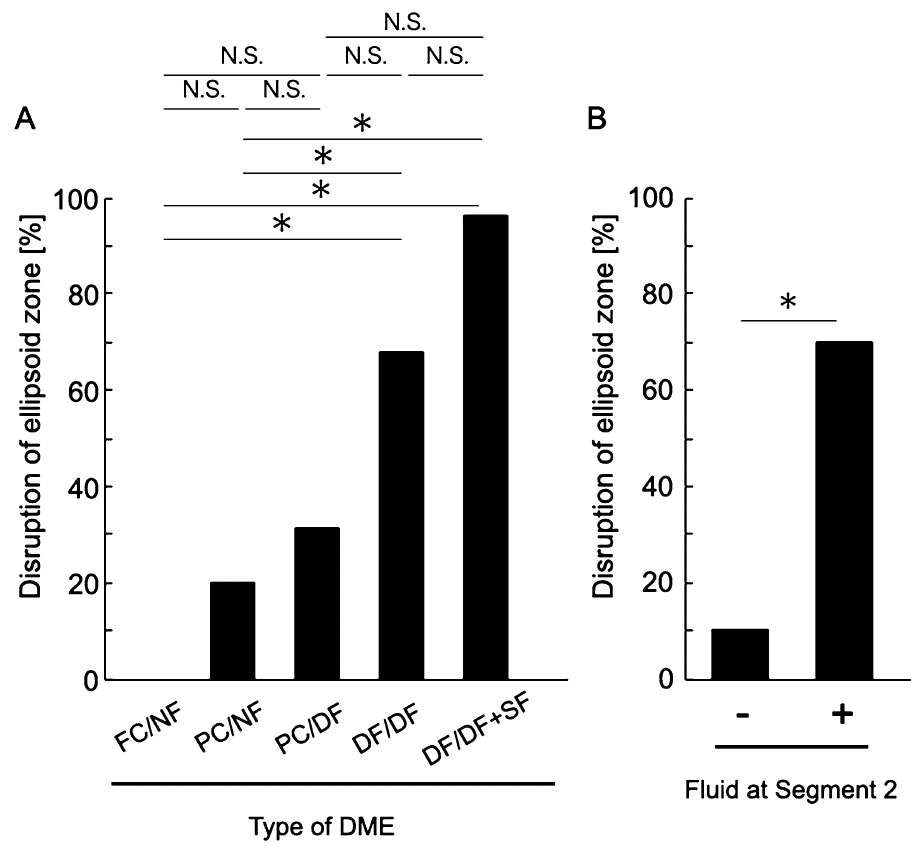
Figure 7. Relationship between ellipsoid zone (EZ) disruption and the en face image-based classification of diabetic macular edema (DME). ( A ) EZ disruption rates are compared among the DME types. ( B ) EZ disruption rates are compared according to the presence or absence of fluid at Segment 2. DME diabetic macular edema, FC/NF foveal cystoid space/no fluid type, PC/NF parafoveal cystoid space/no fluid type, PC/ DF parafoveal cystoid space/diffuse fluid type, DF/DF diffuse fluid/diffuse fluid type, DF/DF + SF diffuse fluid/ diffuse fluid with subretinal fluid type, N.S. not significant, * P <